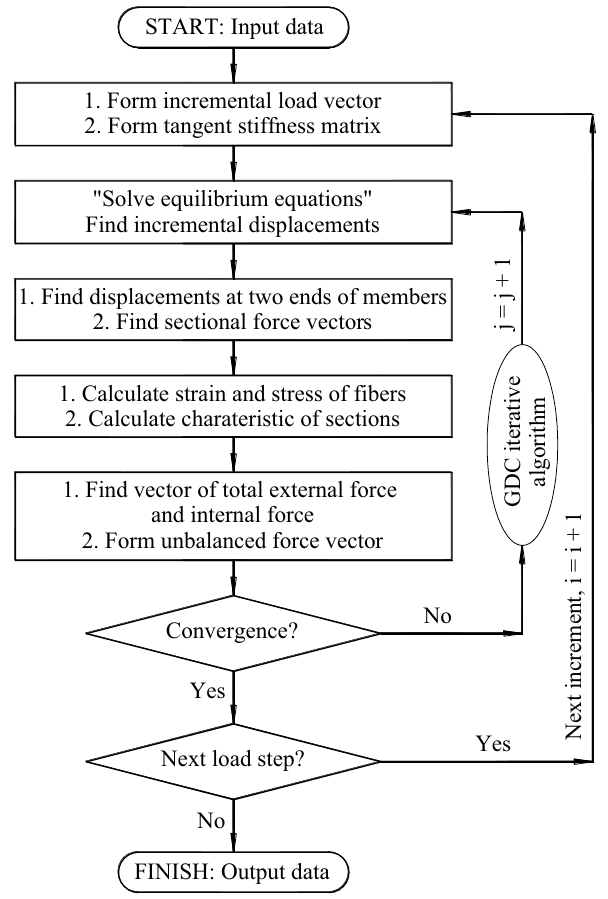
Fig. 3 Flowchart of the proposed